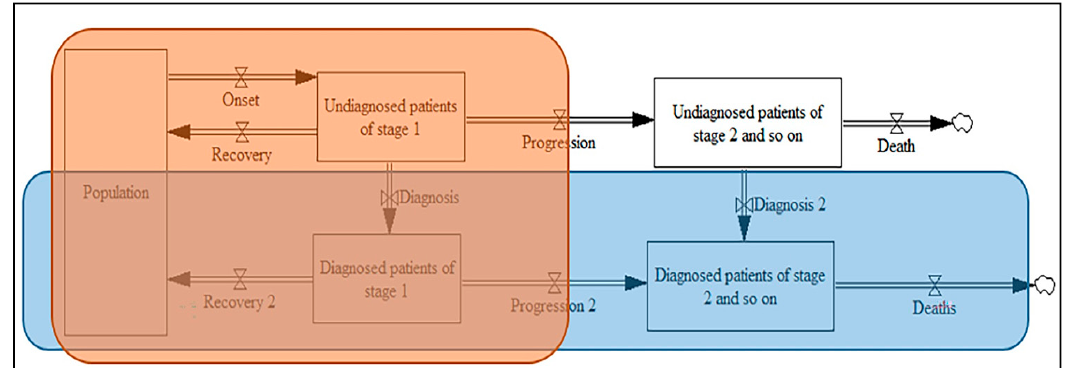
Figure 8. The core part of the stock-flow diagram for chronic diseases.